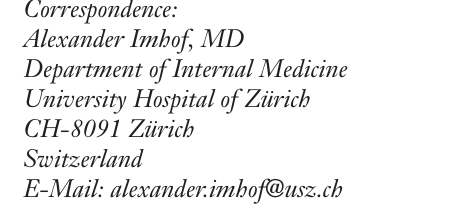
Figure 1 Box-plot of trough voriconazole levels in patiens with and without neurological adverse events (nAE). Thick bar, median level; box, interquar- tile range (IQR); whiskers, minimum and maximum levels after exclusion of outliers; dots, out- liers (values that are more than the third quartile plus 1.5 x IQR).